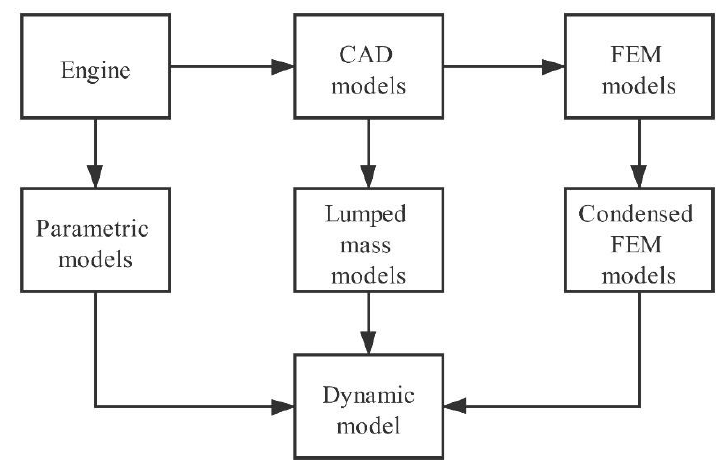
Figure 1. Simplification process of the engine model.